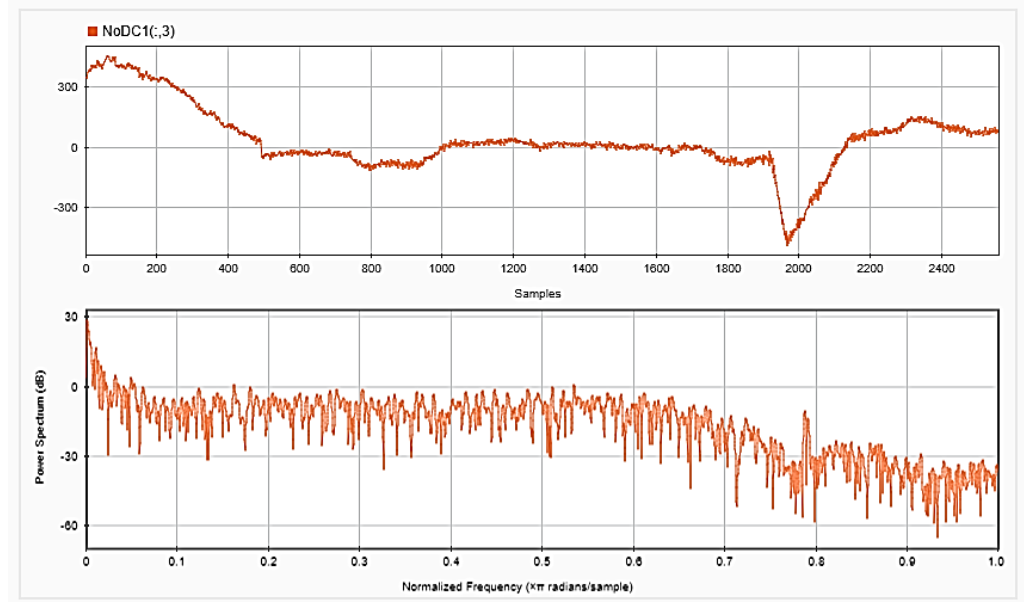
Figure 5. Raw EEG signals for one channel ( upper ), with its power spectral density (PSD) ( lower ).